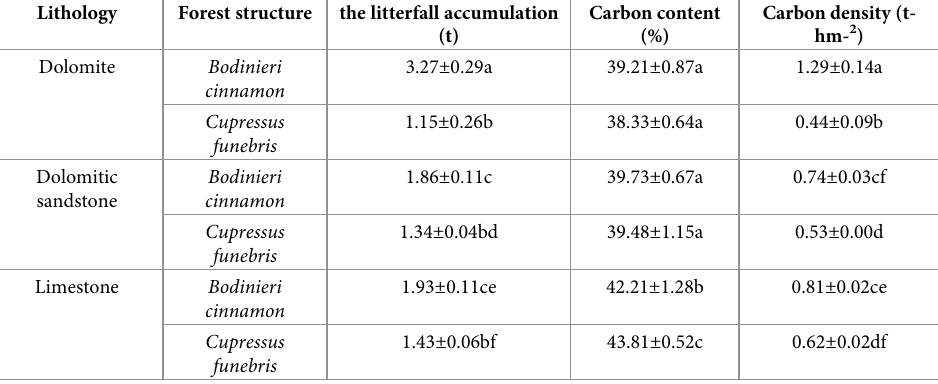
Table 7. Carbon pool characteristics of the litterfall accumulation in the two plantation species under different lithologies.